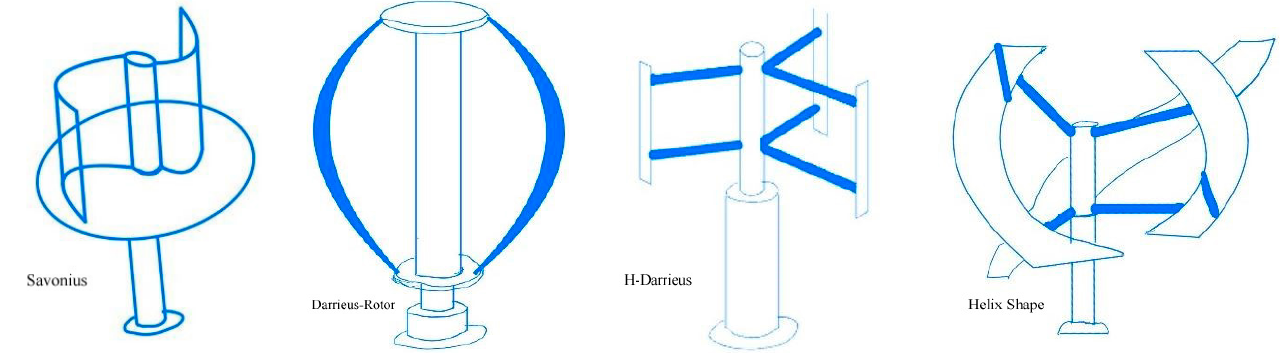
Figure 16. Darrieus and Savonius vertical axial wind turbine (VAWT) with some common designs [25,28,34].